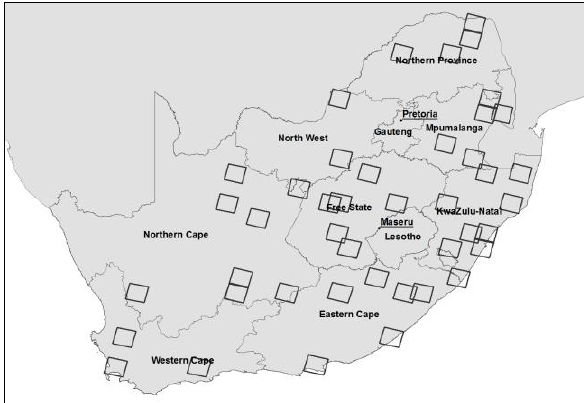
Figure 1. Study area and selected satellite